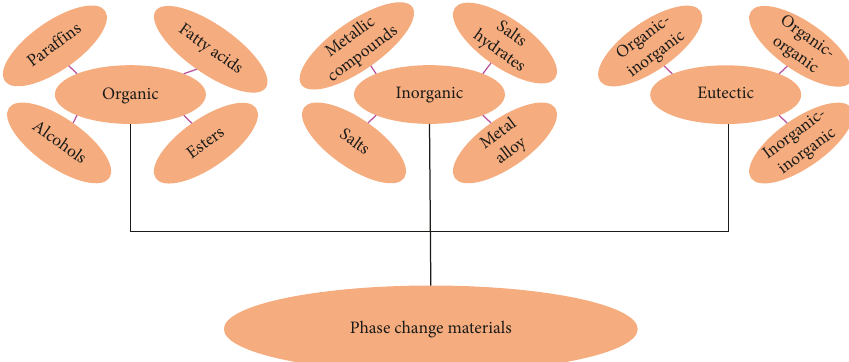
Figure 1: Classification of phase change materials (PCMs).